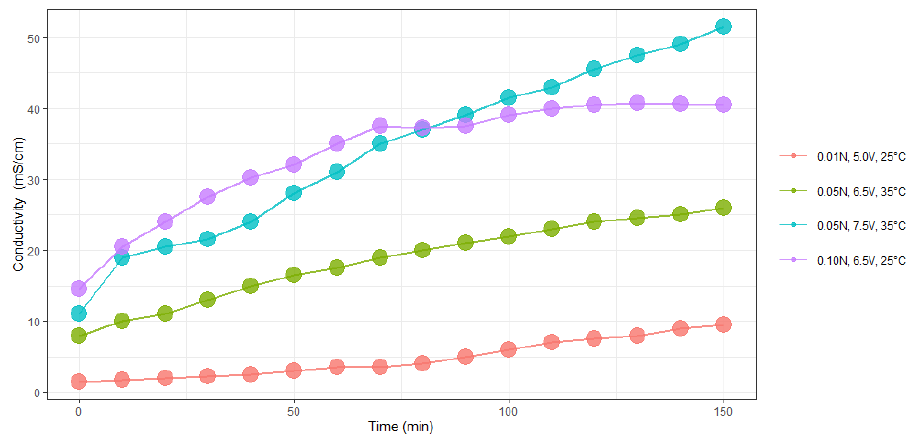
Figure 7. Evolution of the conductivity of NaOH.